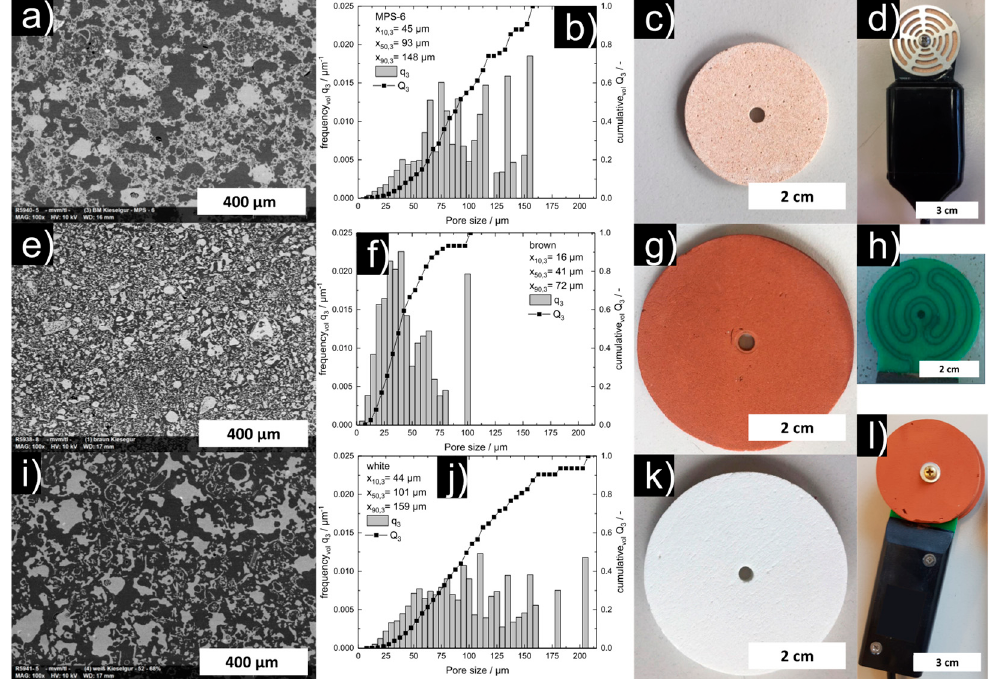
Figure 2. Comparison of the TEROS 21/MPS − 6 − ( top ), the brown ( middle ), and white ceramics ( bottom ): SEM images of polished surfaces of sintered parts (cavities in black and ceramic material in white) ( a , e , i ), pore size distribution q 3 (x pore ) and Q 3 (x pore ) ( b , f , j ), top view of the ceramics ( c , g , k ), top view of the sensor ( d , l ), and the electrode of the TDT sensor ( h ).